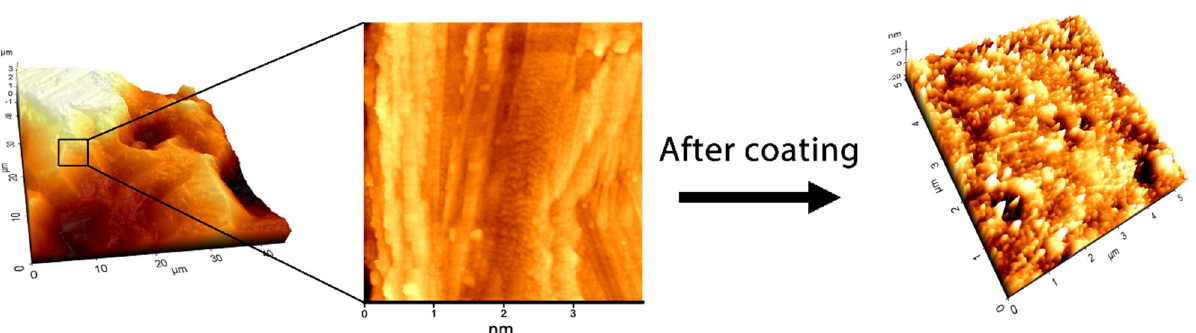
Figure 5. Water wettability assay of the different biomaterial surfaces. The hydrophilicity assay indicated that by increasing the percent of surface calcium oxide, its hydrophilicity can be significantly increased. Furthermore, although all of the surfaces were hydrophilic, the 5% calcium oxide and the conventional titanium surfaces were significantly more hydrophilic than rest of the biomaterials. Each alphabet represents an individual statistical group. (One way ANOVA, p > 0.05).